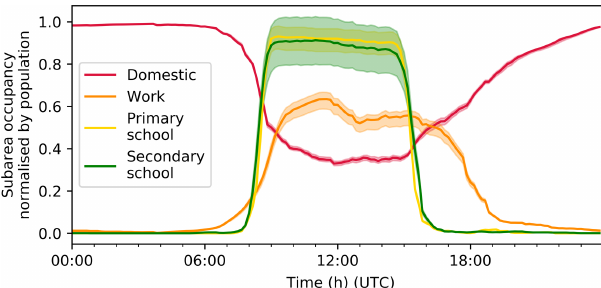
Figure 3. Median (line) and IQR (shading) of total occupancy of each a N in Greater London for 1 weekday (R2, Table 6), normalised S by actual static population (Table